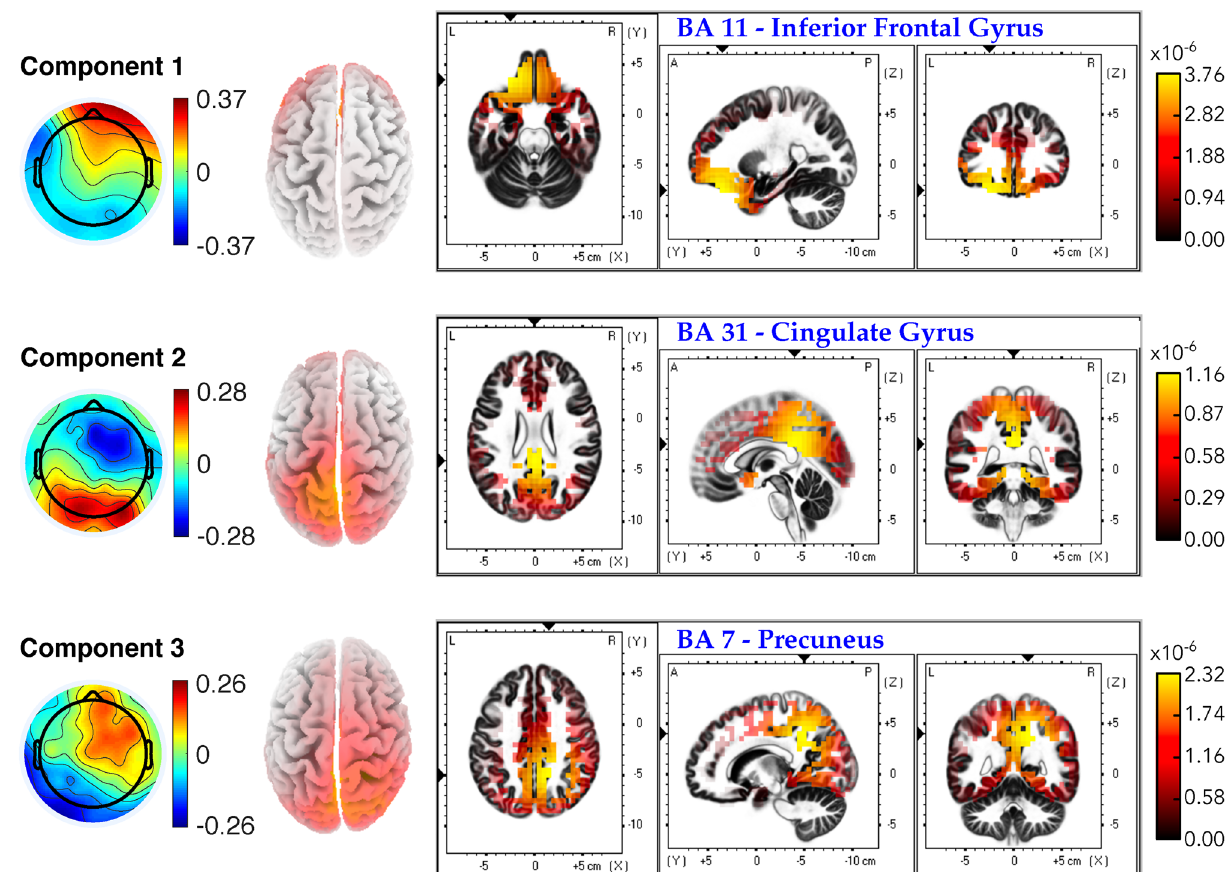
Figure 8. Neural source localization results for the first three ITC components. The scalp projections are shown in the leftmost column for respective components. The second column presents the estimated source distributions (top view). The remaining plots exhibit three orthogonal slices corresponding to the primary sources of the localization results. Full views of 3D source distributions for each component were depicted in Figure SC.2 of Supplementary Material